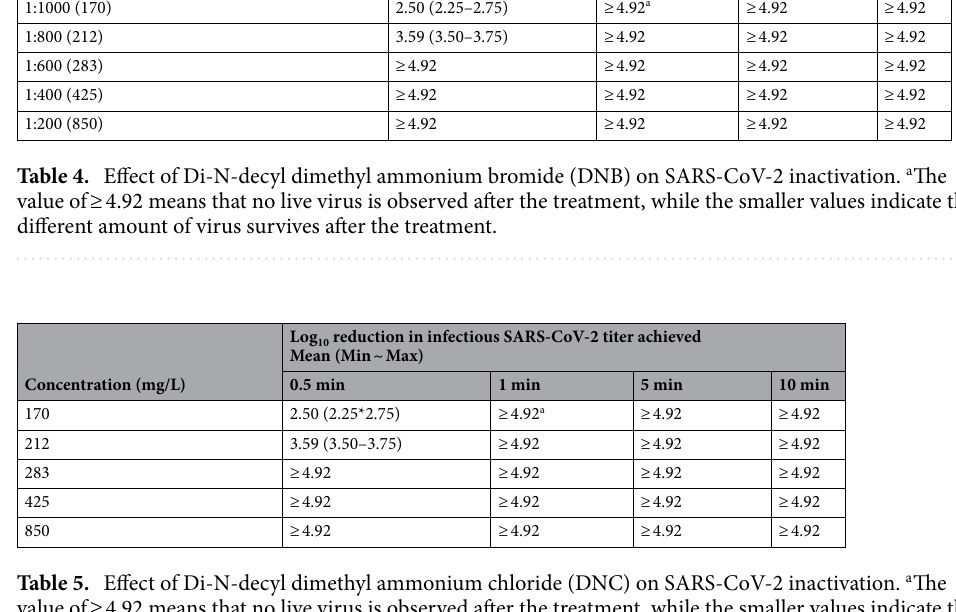
Dilution ratio (concentration, mg/L)